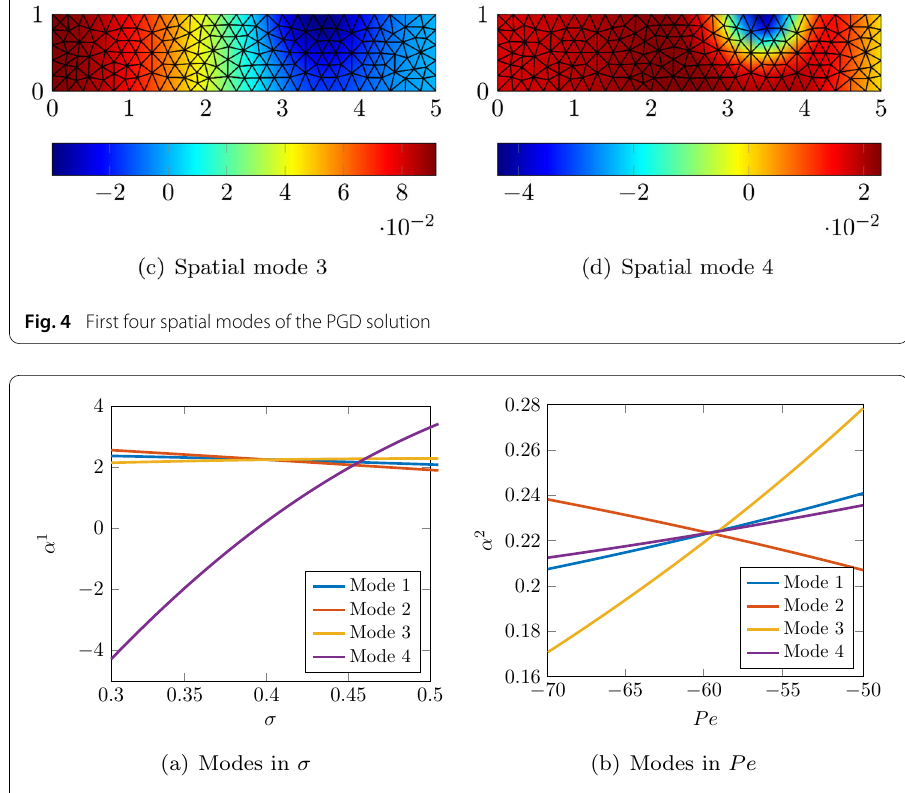
Fig. 5 First four parametric modes of the PGD solution probability for the model M to predict observations d obs given values of the